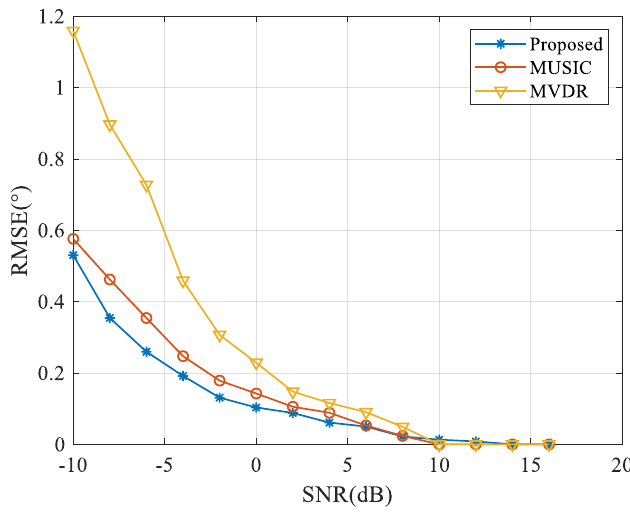
Figure 6. Results of root mean square error (RMSE) versus SNR under near-field INR of 50 dB.